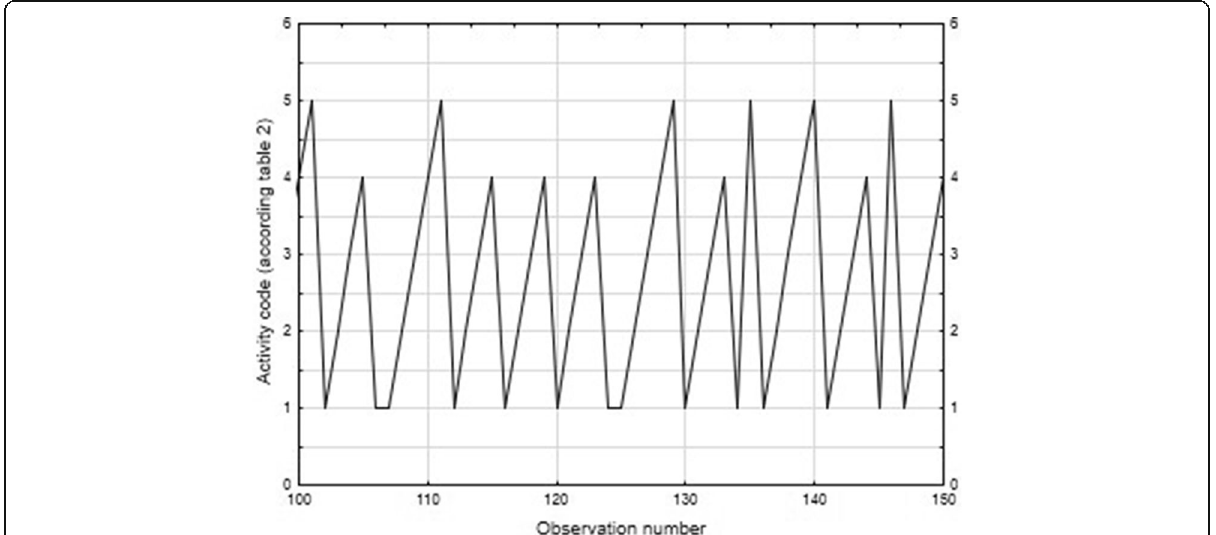
Fig. 3 Fragment of a time series of operations performed by a harvester in mature stands